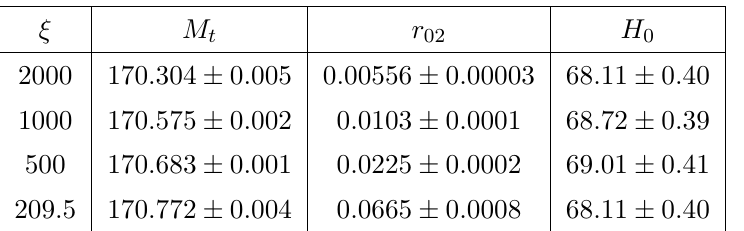
Table 2 . Constraints on the theory parameters using the Planck TT, TE, EE + lowE + lensing + BICEP 2 /Keck + BAO + Pantheon combination. Quoted intervals correspond to 68% C.L.